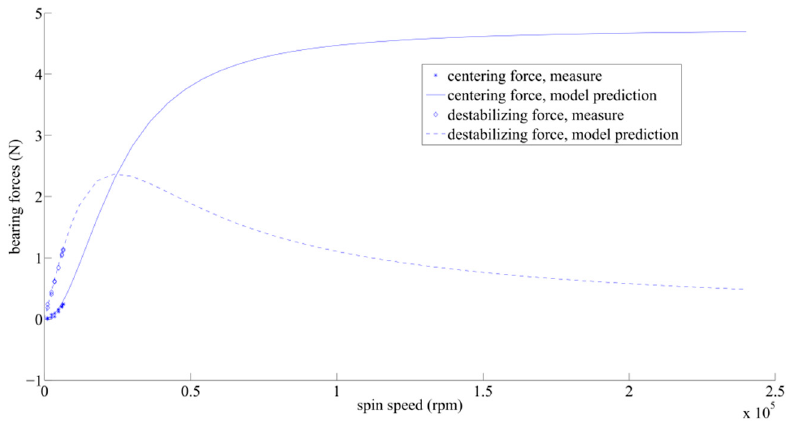
Figure 18. Bearing forces as a function of the spin speed for a center shift of 0.75 mm, experimental measures, and model predictions with model parameters identified by curve fitting.